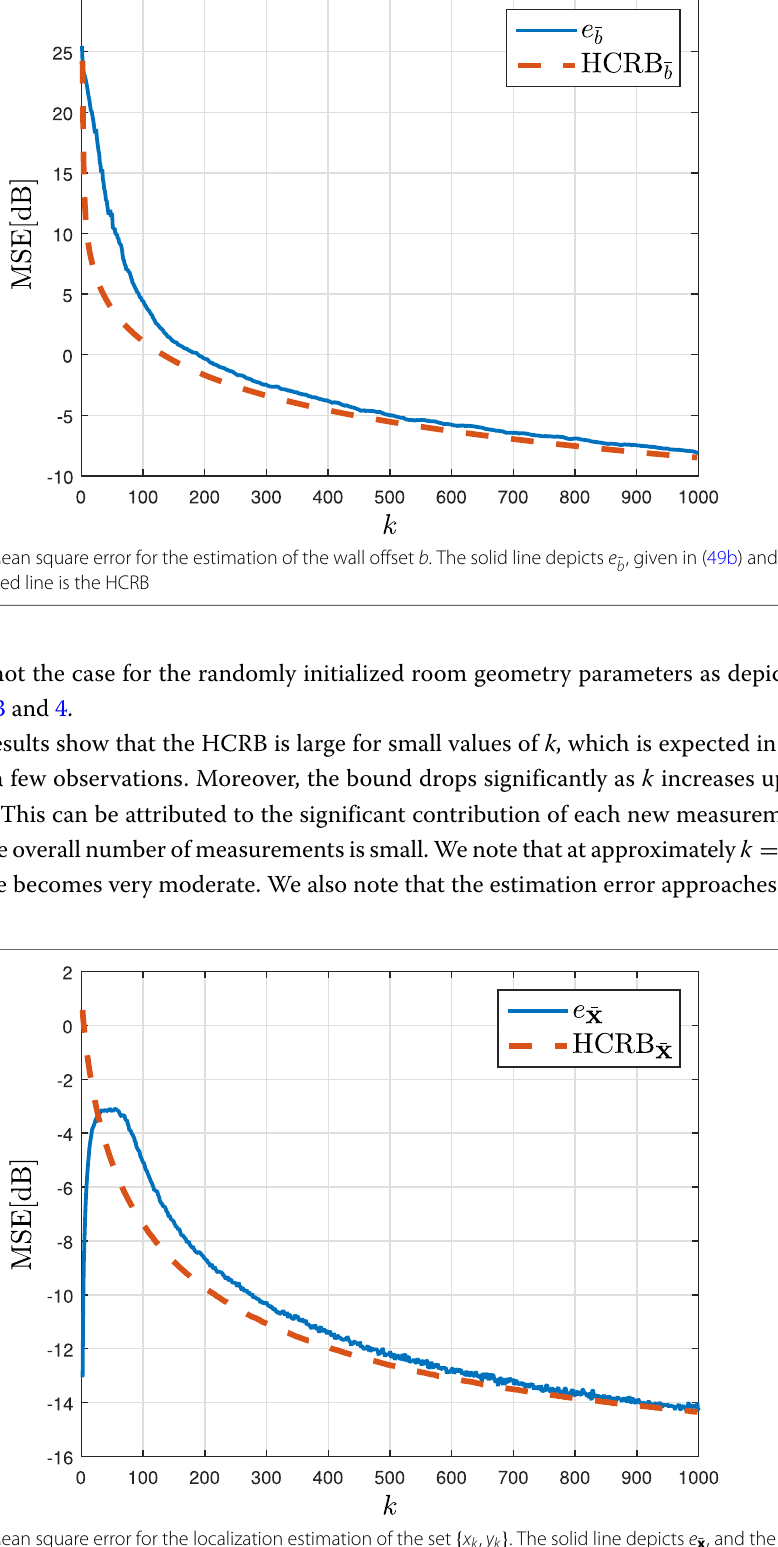
Fig. 5 Mean square error for the localization estimation of the set { x k , y k } . The solid line depicts e ¯ x , and the dashed line is the